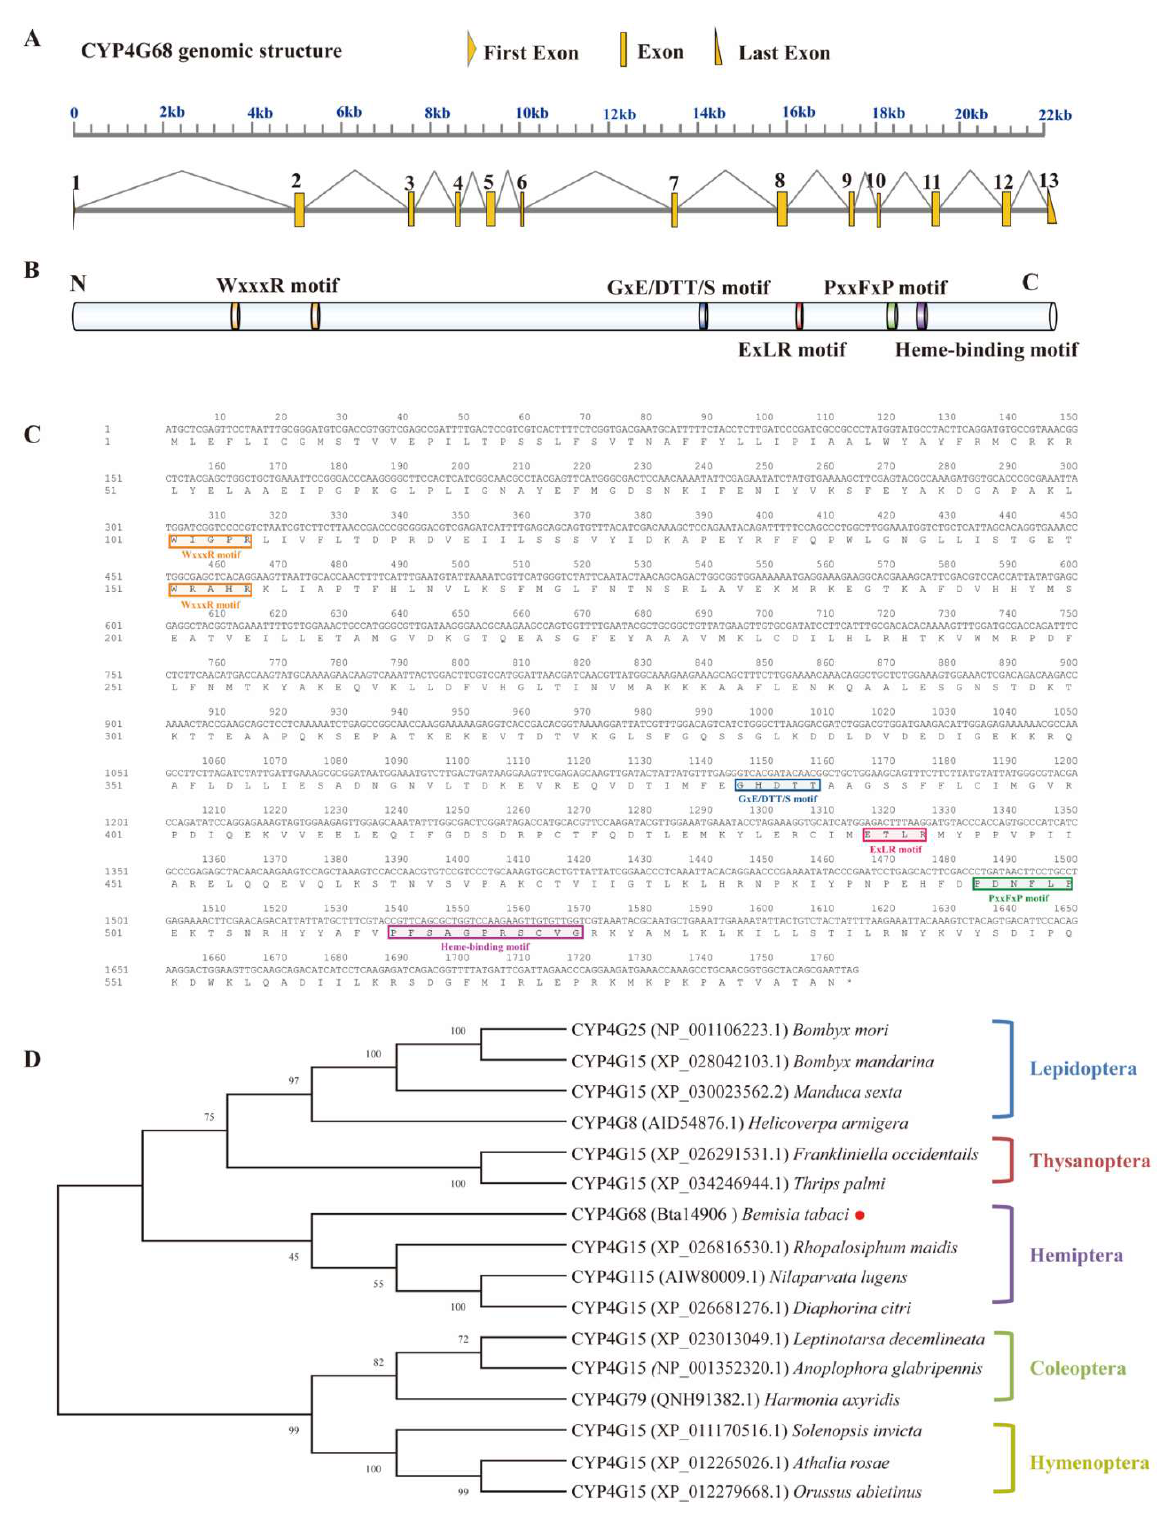
Figure 2. Bioinformatic analysis of CYP4G68 . ( A ) Genomic structure analysis of CYP4G68 . ( B ) Five conserved domains present in CYP4G68 that are common to cytochrome P450s. ( C ) The full-length gene that encodes CYP4G68 in B. tabaci contains a 1764-bp ORF encoding 587 amino acid residues and the specific locations of the five conserved domains. ( D ) Phylogenetic tree of CYP4G68 from B. tabaci and related P450s from other insects. Bootstrap values (1000 replicates) are indicated next to the branches, and GenBank accession numbers are shown in parentheses. The red dot indicates CYP4G68 in B. tabaci